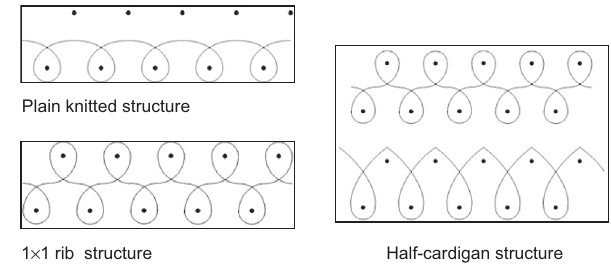
Figure 1 Loop notations of three different